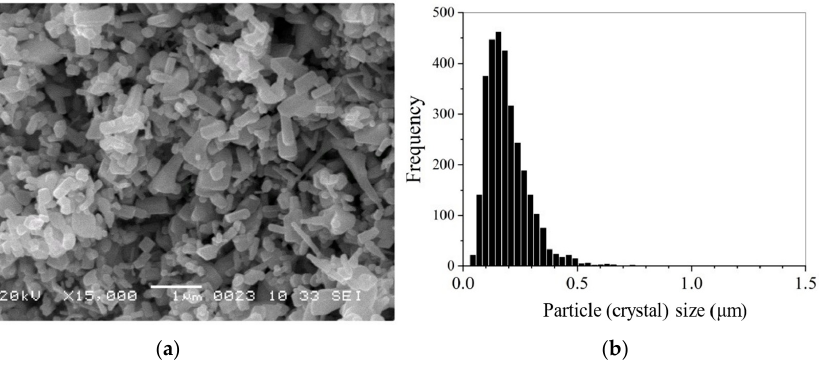
Figure 3. SEM image ( a ) and crystal size distribution ( b ) of the initial ZnO powder. Mean size d mn = 0.193 ± 0.002 μ m, median size d md = 0.174 ± 0.002 μ m.